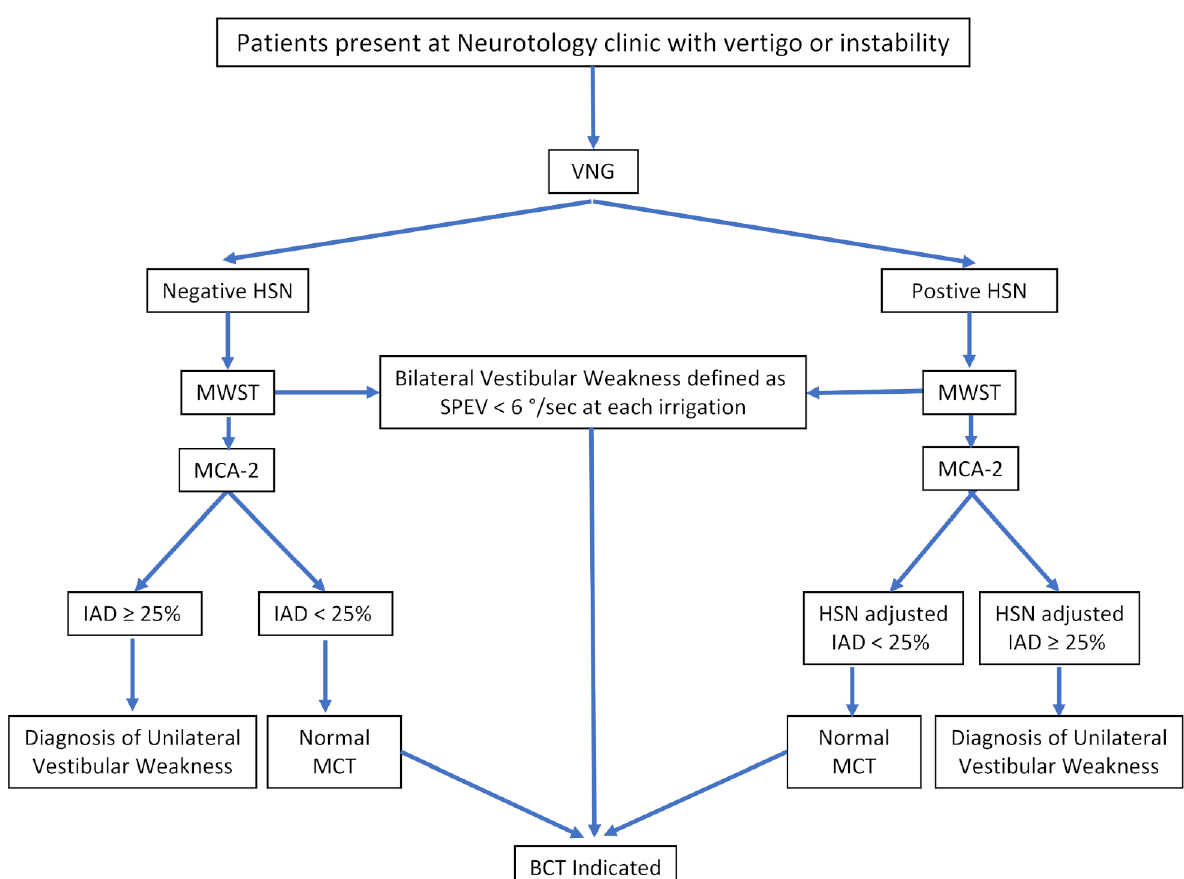
Figure 4. Diagnostic Algorithm of monothermal warm stimulating test. VNG: Videonystagmogram; HSN: Horizontal Spontaneous Nystagmus; MWST: Monothermal Warm Stimulation test; MCA: Monothermal caloric asymmetry; MCA-2 formula: MCA-2 = (Right − Left) × 100/(Right + Left); IAD: Inter-auricular Difference; SPEV: Slow-Phase Eye Velocity; BCT: Bithermal Caloric Test; MCT: Monothermal caloric